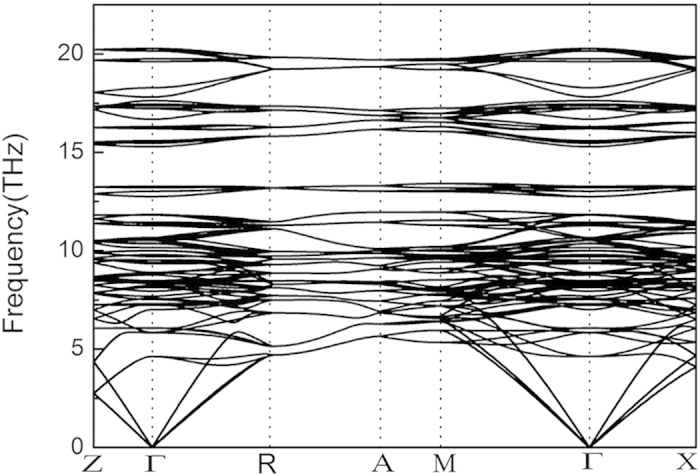
Phonon dispersions of the Cr5B3-type V5C3 at zero pressure along high symmetry directions of the Brillouin zone.